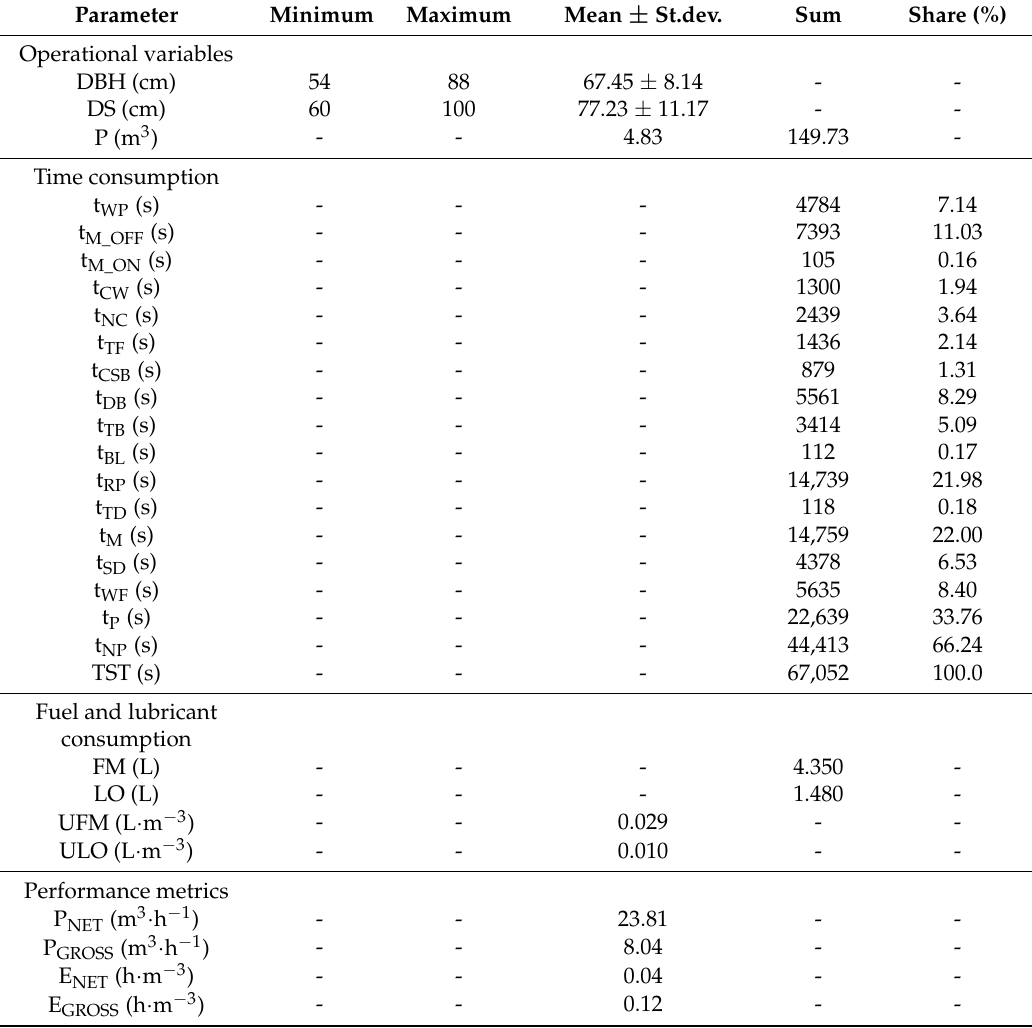
Table 3. Summary description of time, fuel, lubricant consumption, and estimates of productive performance, St.dev.: standard